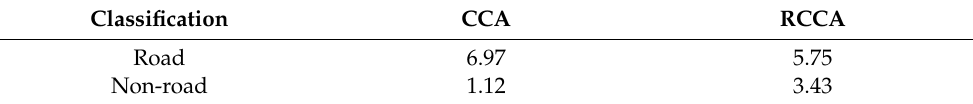
Table 7. The energy comparison of CCA and RCCA sampling.